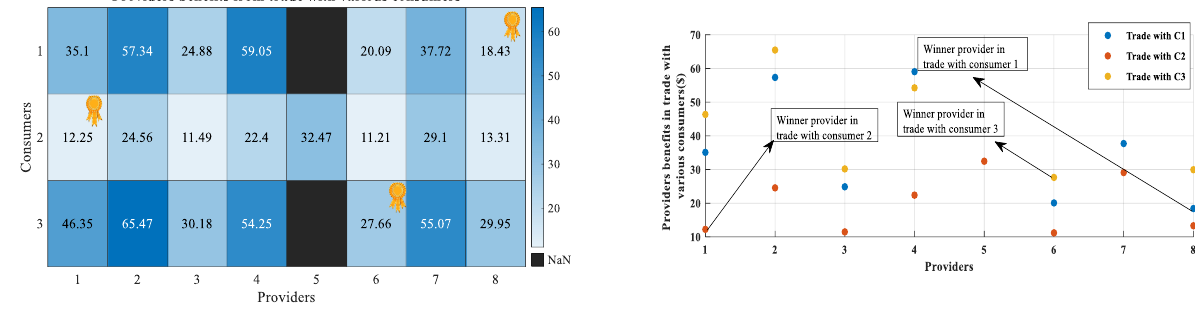
Figure 6. Heatmap and scatter plots of Providers benefits from trade with various consumers.